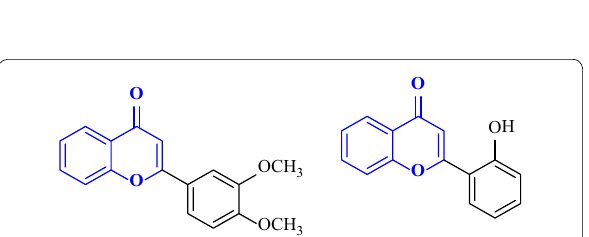
Fig. 61 Molecule structures of compounds C60 and